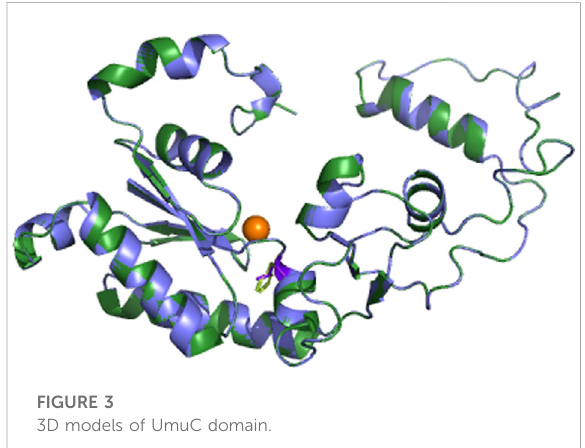
FIGURE 3 3D models of UmuC domain.